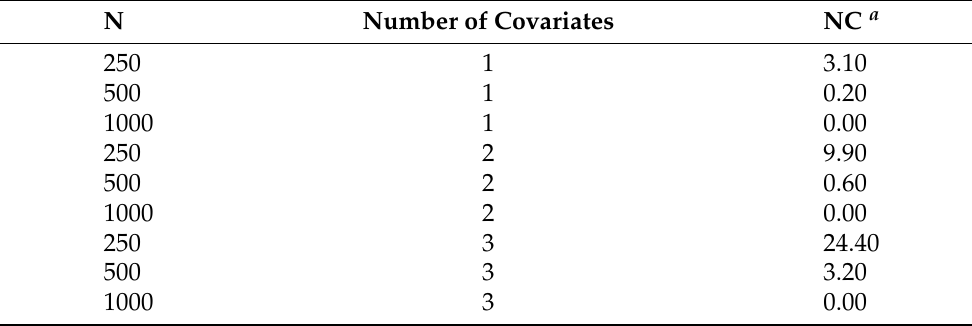
Table A1. Non-Convergence of the Iterated IPC Regression